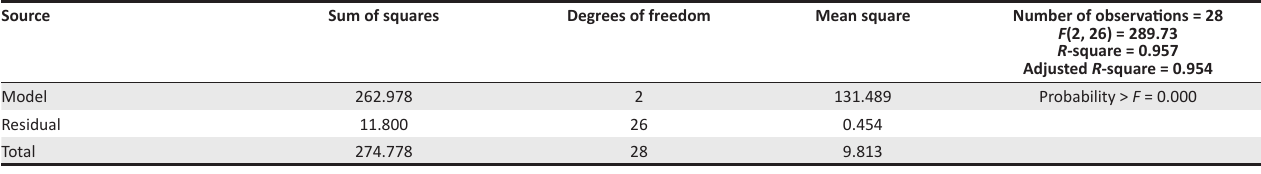
TABLE 5a: Organisational performance.